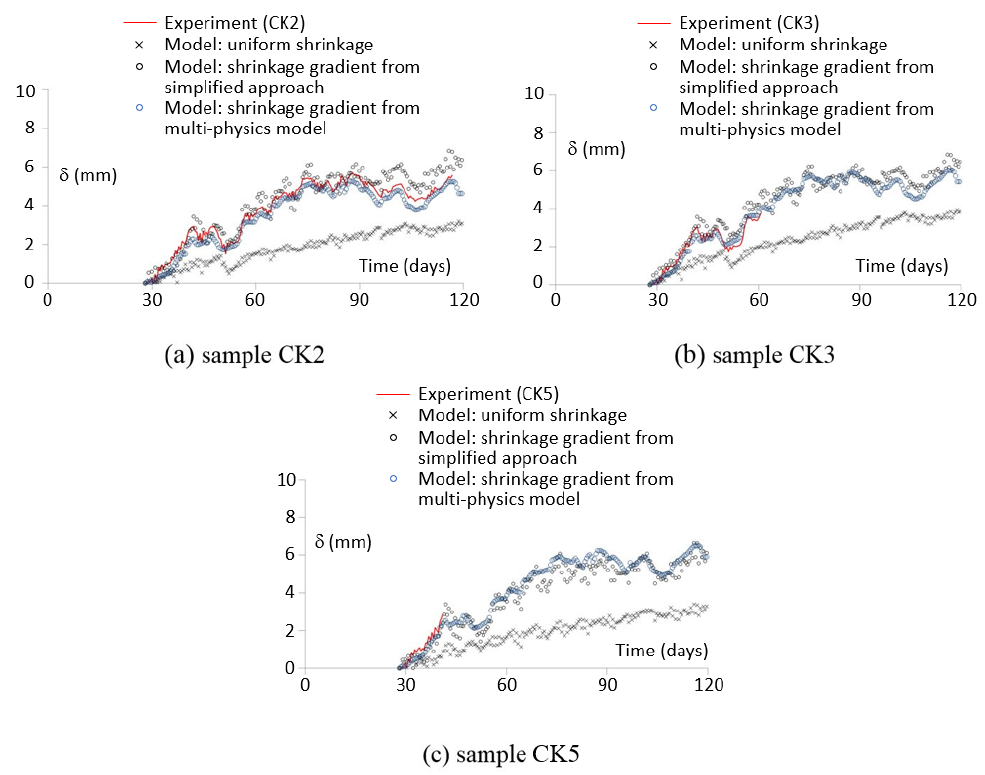
Figure 7. Experimental and numerical mid-span deflections considering different shrinkage profiles [68]. files